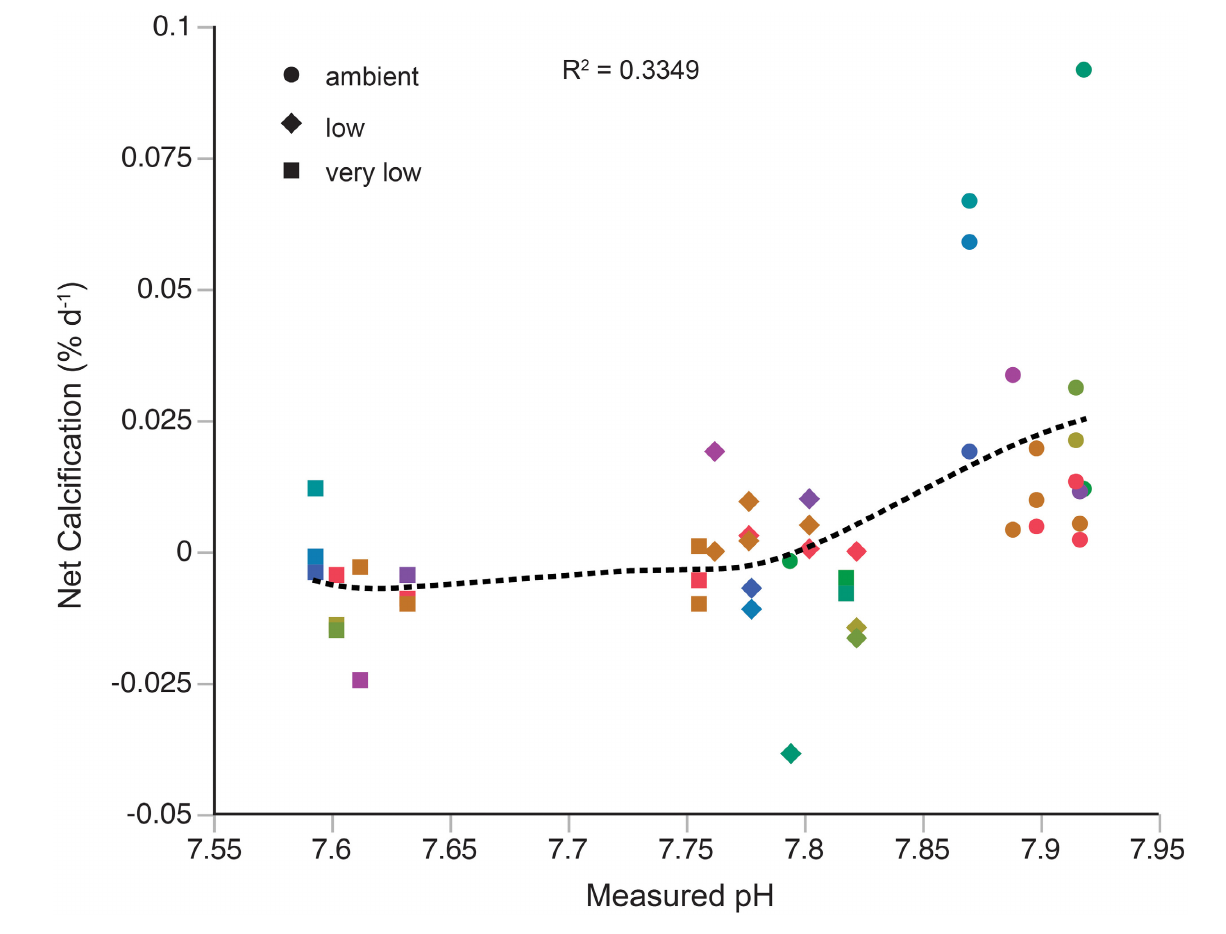
FIGURE 2 | L. pertusa calcification responses to acidification treatments. Each color represents a unique genotype. Dashed black line represents a linear local regression (LOESS) of calcification data against measured